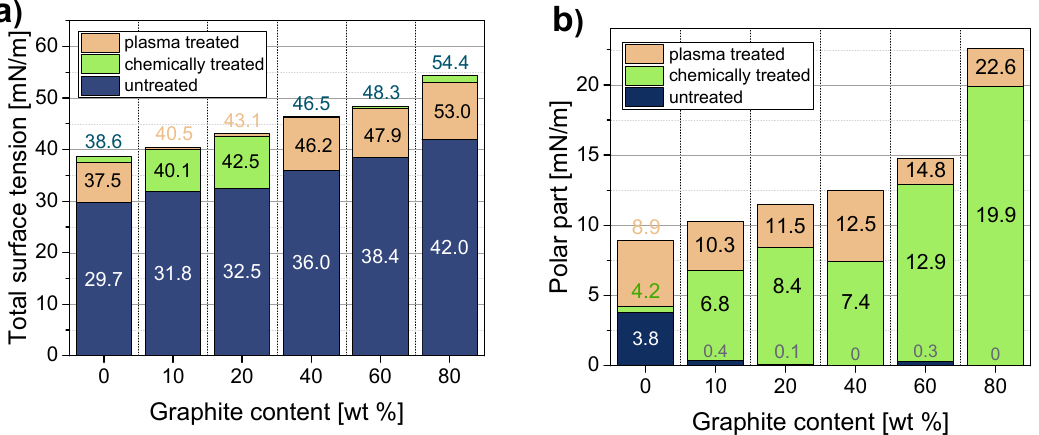
Figure 6. Effect of surface treatment on ( a ) total surface tension and ( b ) its polar part of pure PP and PP/graphite composites.